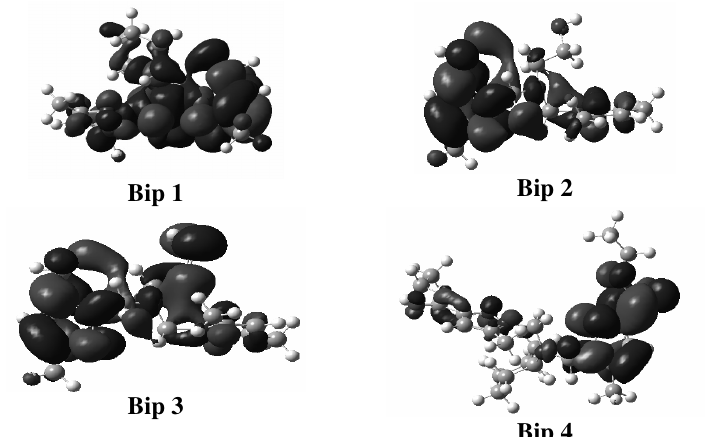
Figure 3. The highest occupied molecular orbital (HOMO) of the inhibitors.